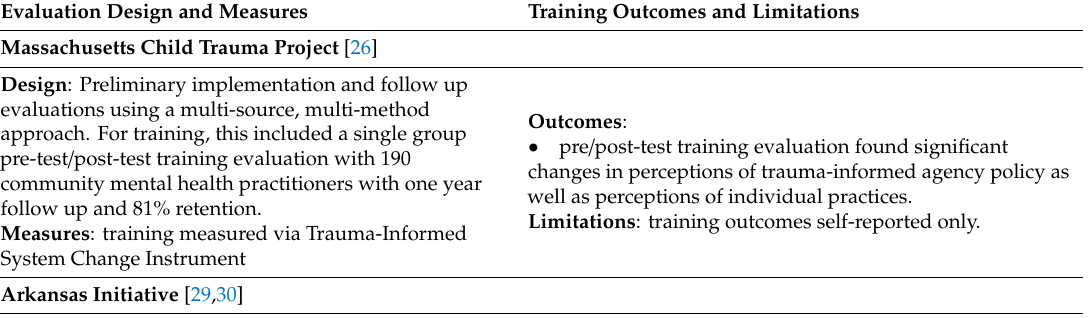
Table 4. Empirical training outcomes ( n =